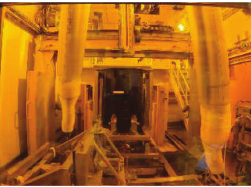
Fig. 12. Installation of an 870 l drum in